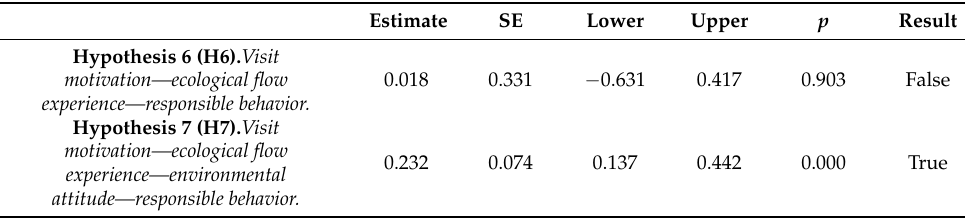
Table 8. Intermediate effect test.